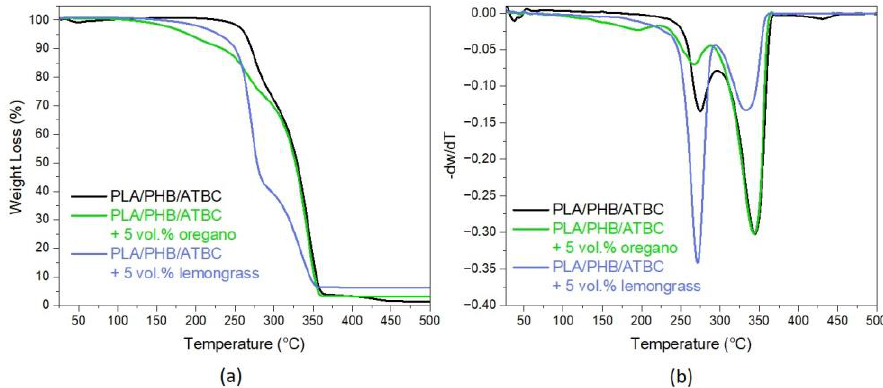
Figure 5. ( a ) TGA thermograms for electrospun neat PLA/PHB/ATBC and composites: PLA/PHB/ATBC + 5% oregano EO and PLA/PHB/ATBC + 5% lemongrass EO. ( b ) Graphs of 1st derivation of TGA.